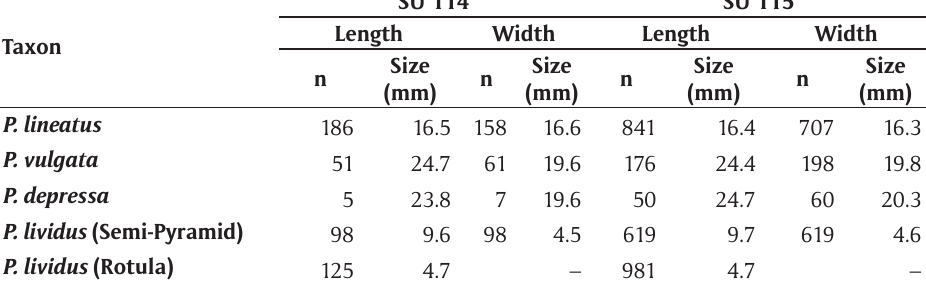
Table 3: Biometrical data (length and width) of the most abundant species at El Mazo.